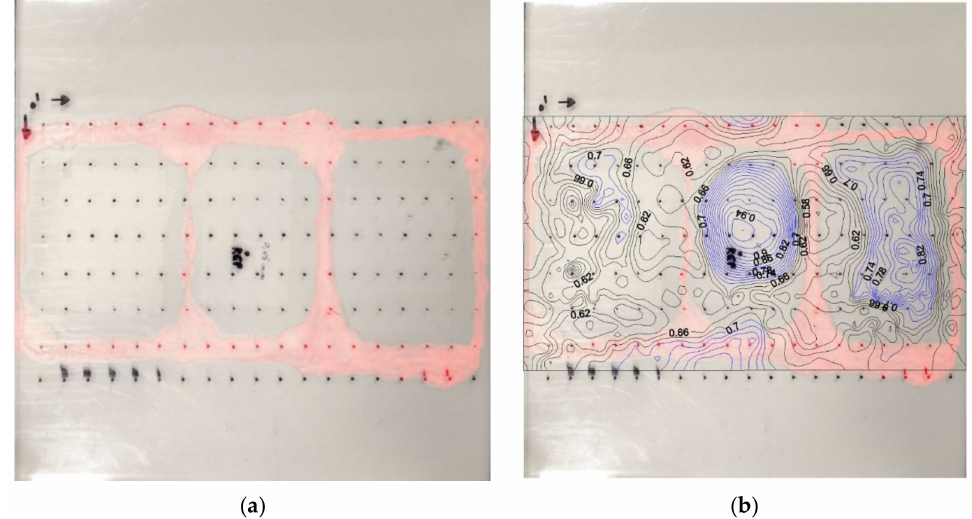
Figure 8. The test object 1 made in the laboratory. It is a 4.8 mm thick PMMA slab, glued using cyanoacrylate as shown in ( a ) on a 20 × 20 cm tile used as a base. The measurement carried out was reported in ( b ) using the contour lines